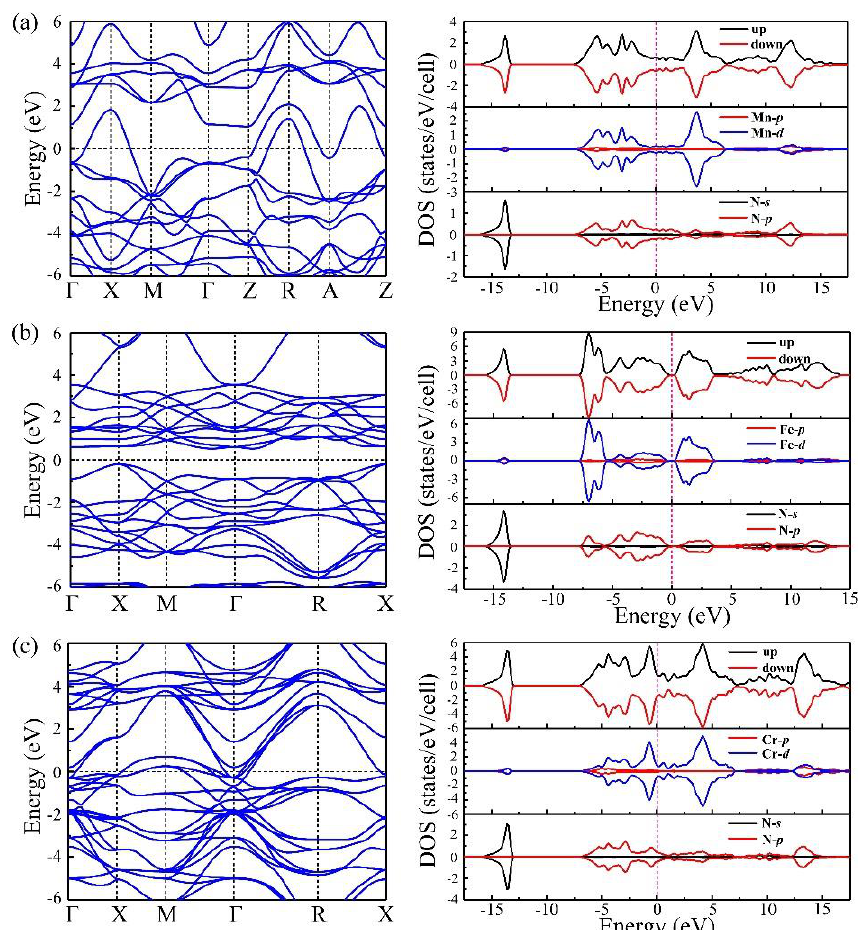
Figure 5. ( a ), ( b ), and ( c ) show the band structures and density of states (DOS) of I 4 /mmm – MnN, F 4̅ 3m – FeN, and Fm 3̅ m – CrN at zero pressure, respectively. The dashed lines show the Fermi level. For the density of states, the top, middle, and bottom part represent the total DOS, partial DOS of transitional metal elements, and partial DOS of N, respectively.